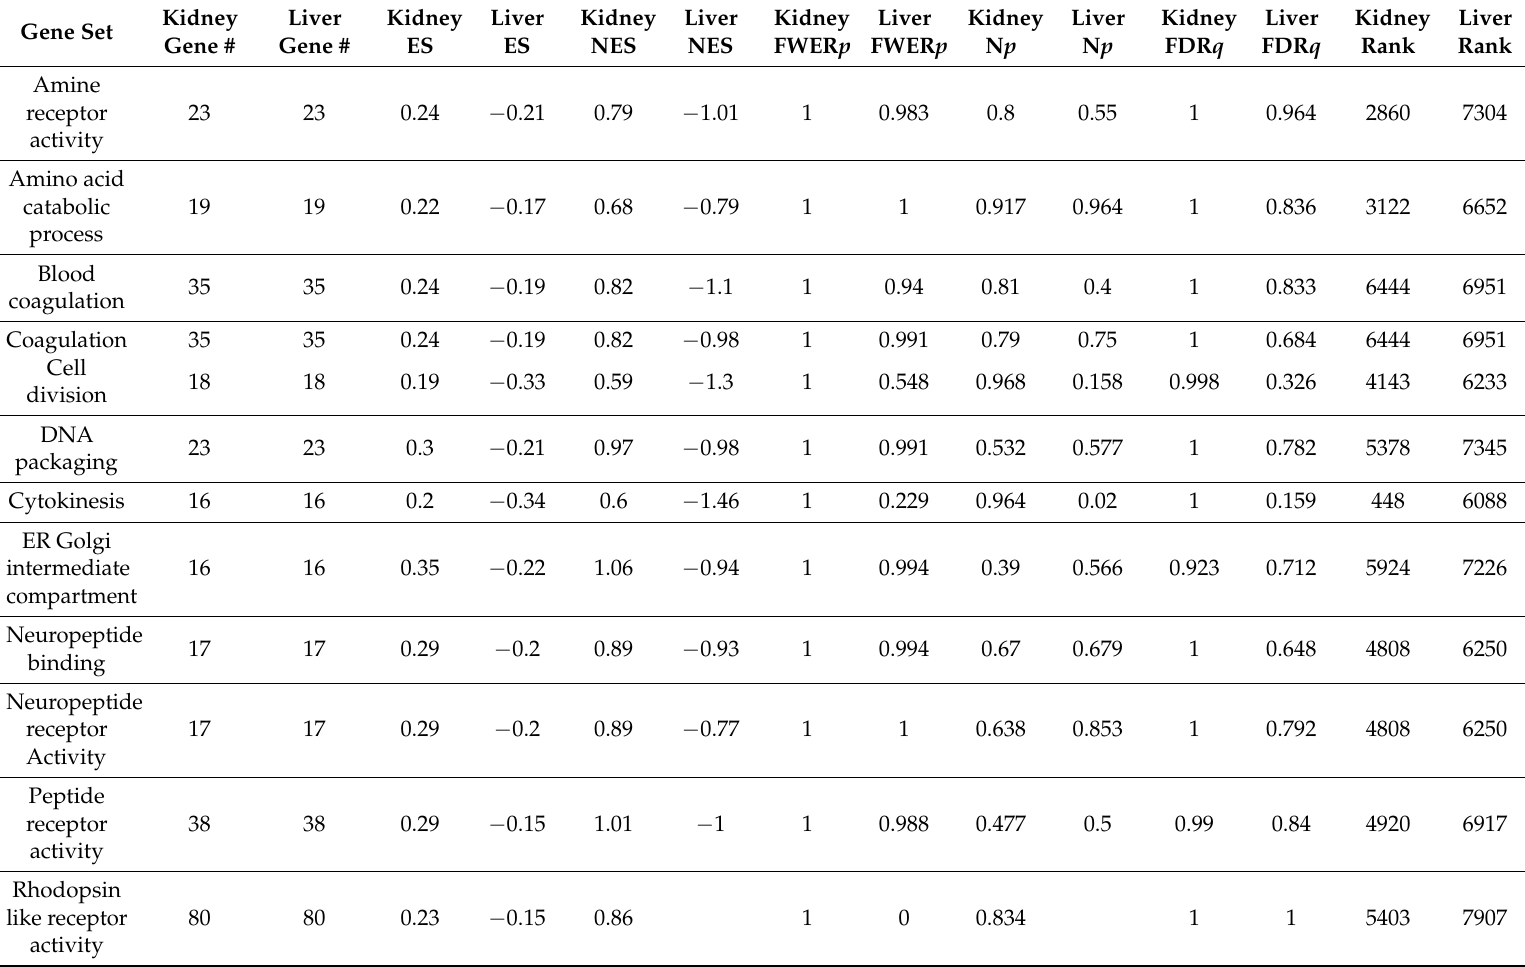
Table 2. Genes Upregulated in Kidney and Downregulated in Liver during